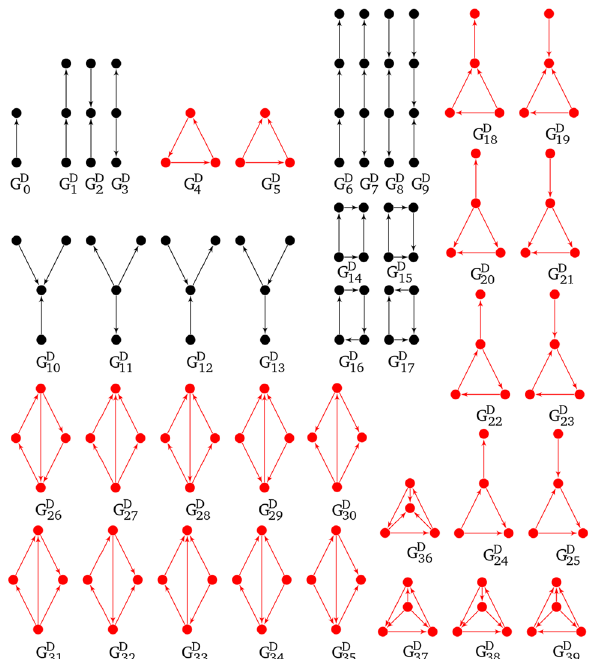
Figure 5. All directed graphlets build on 2, 3 and 4 vertices. The ones in black color can occur in Petri